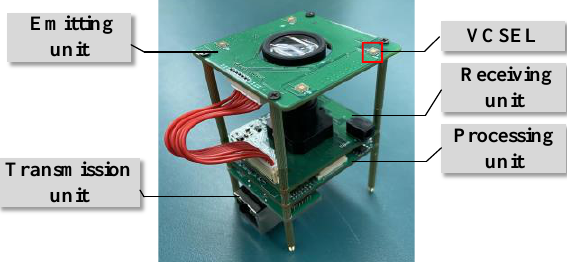
Figure 8. The PMD solid-state array Lidar.